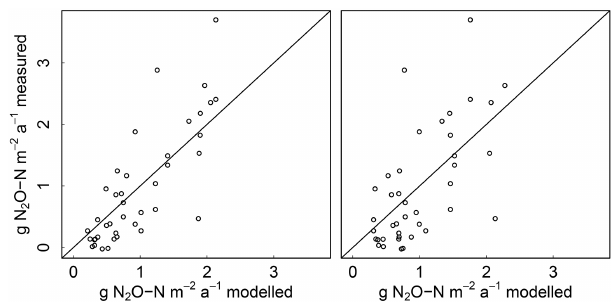
Figure 4. Fuzzy model performance for calibration and cross vali- dation of N 2 O fluxes from cropland on organic soils. The modelled fluxes ( x axis) represent the mean flux rates from a model ensemble of 50 individually bootstrapped models. The cross validation was performed by excluding one site per iteration.